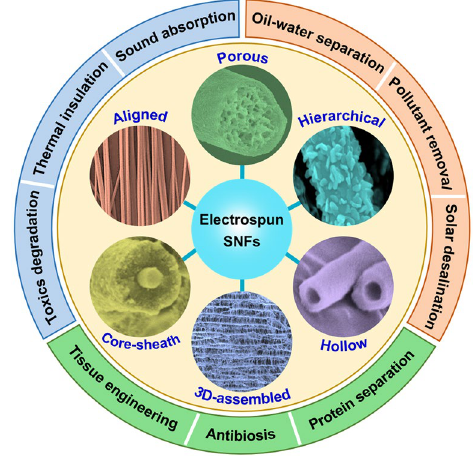
Fig. 1 Applications of electrospun SNFs with various structures in many fields. Different SNFs with core‑sheath [35], hollow [36], porous [37], hierarchical [38], aligned [39], and 3D‑assembled struc‑ tures [40]. Reproduced with permission from Ref. [35]. Copyright 2013, American Chemical Society. Reproduced with permission from Ref. [36]. Copyright 2009, to the authors (Ming Zhou et al.). Repro‑ duced with permission from Ref. [37]. Copyright 2019, Elsevier. Reproduced with permission from Ref. [38]. Copyright 2014, The American Ceramic Society. Reproduced with permission from Ref. [39]. Copyright 2017, Elsevier. Reproduced with permission from Ref. [40]. Copyright 2018, American Association for the Advance‑ ment of